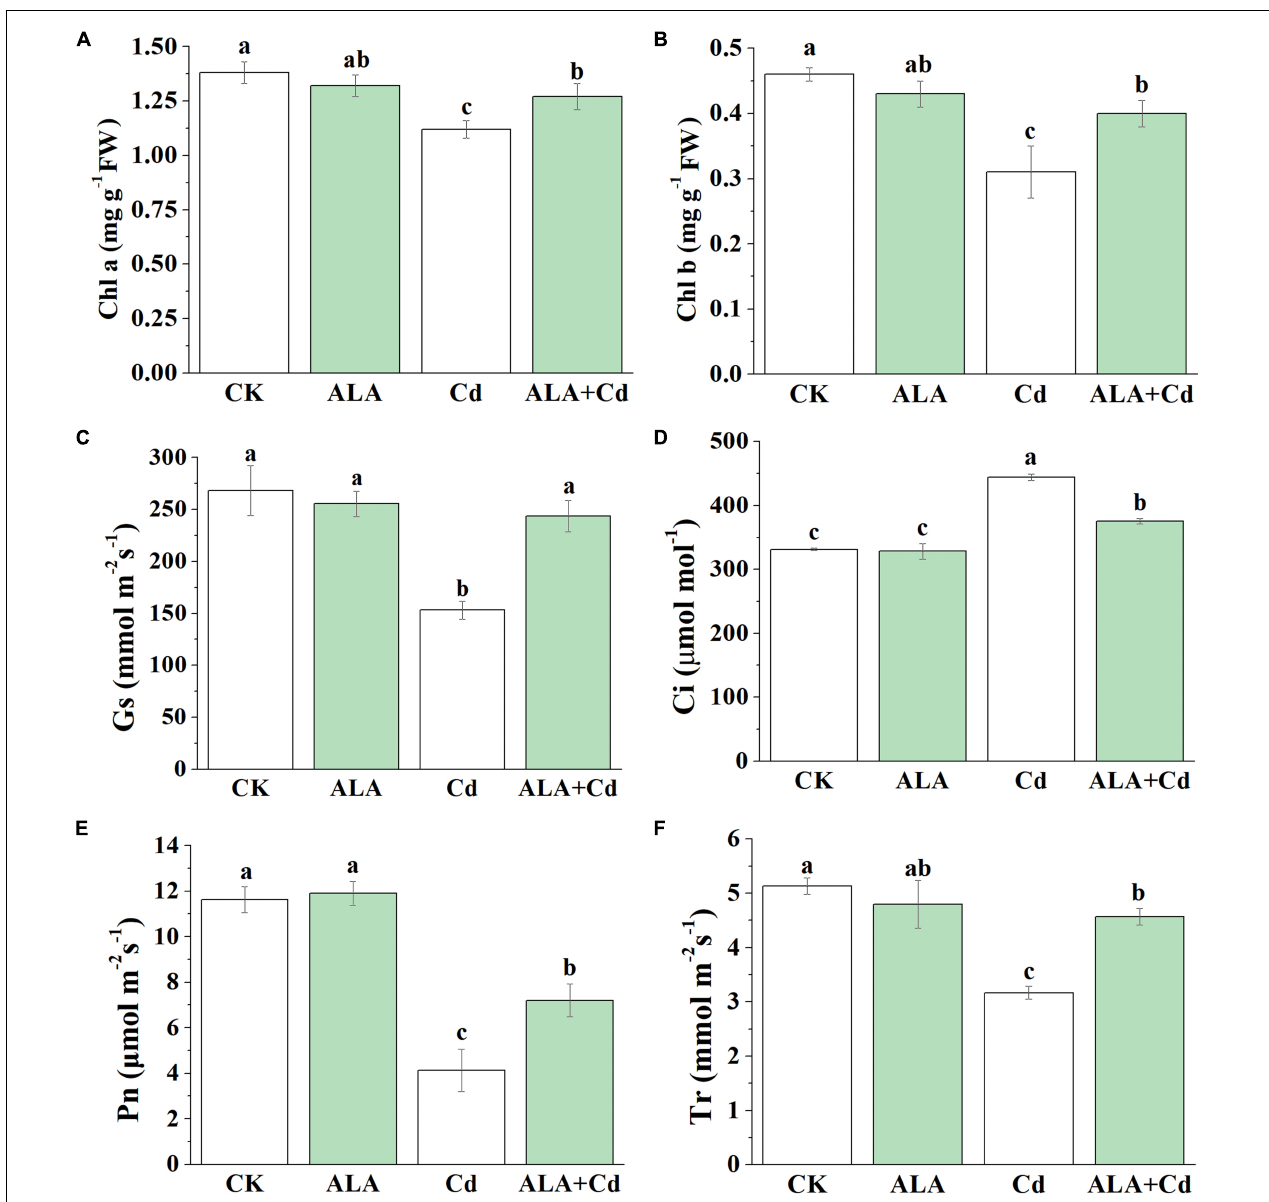
FIGURE 2 | Effects of ALA under Cd stress on Chlorophyll content and photosynthetic gas exchange parameters of cabbage. (A) Chl a , (B) Chl b , (D) intercellular CO 2 concentration (Ci), (C) stomatal conductance (Gs), (E) net photosynthetic rate (Pn), and (F) transpiration rate (Tr). The mean ± SE are shown ( n ≥ 3). The seedlings were treated as in Figure 1 . Different letters indicate significant difference among the treatments ( P <